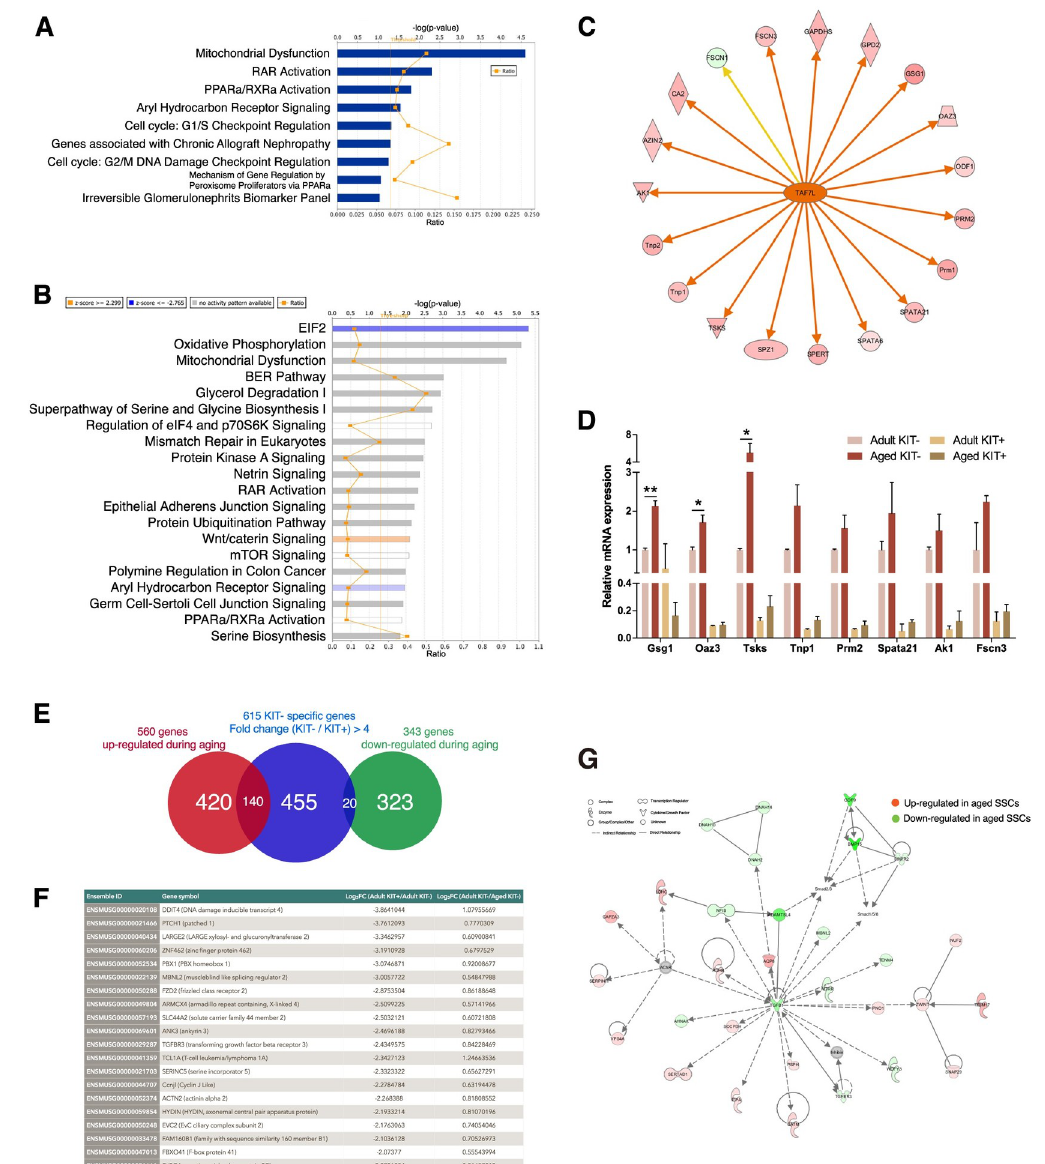
Fig 2. Genes and pathways associated with the maintenance and aging of adult SSCs. (A) Ingenuity pathway analysis (IPA) gene ontology analysis on the differentially expressed genes between adult and aged SSC showing Top toxicity target lists identified. (B) Top 20 canonical pathways as revealed by Ingenuity pathway analysis (IPA) gene ontology analysis on the differentially expressed genes between adult and aged SSC. (C) Inference of Taf7l regulation from the aging SSC transcriptome. Upstream regulator analysis by Ingenuity pathway analysis (IPA). Data illustrate Taf7l as “activated” in aged cells in upstream regulator analysis. Genes in red were greater expressed in aged cells compared with young adults, whereas genes in green were lower expressed. An orange line indicates predicted upregulation, whereas the yellow line indicates expression being contradictory to the prediction. (D) RT-PCR analysis of expression of Taf7l downstream targets showing greater expression in IPA in aged cells compared with adult cells (n = 2, unpaired t-test). Error bars are plotted with SD. (E) Aging-associated differential expression of the KIT- preferential genes. Venn diagram of the overlap between genes differentially expressed upon aging and genes highly enriched in KIT- cells. (F) The full list of the KIT- preferential genes showing down-regulation upon aging. (G) Inference of TGF- β signaling from the aging SSC transcriptome. Shown is the network from Ingenuity Pathway Analysis (IPA) consisting of TGF- β 1 regulators (e.g., TGFB1, TGFBR3, and BMP5) and the subset of SSC aging differentially expressed genes. Symbolic representations of genes, expression changes, and regulatory relationships are shown on the top.